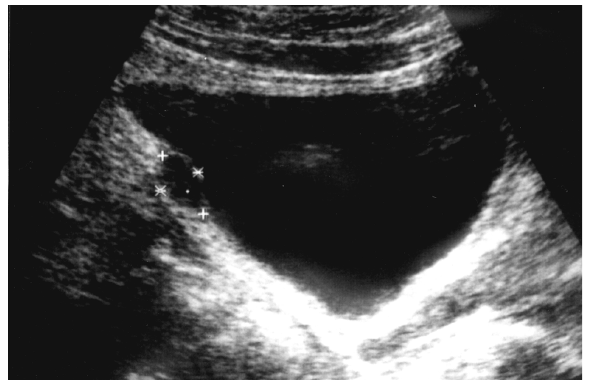
Figure 1 – Ultrasonography (longitudinal scan) demonstrat- ing the bladder tumor (intramural leiomyoma).